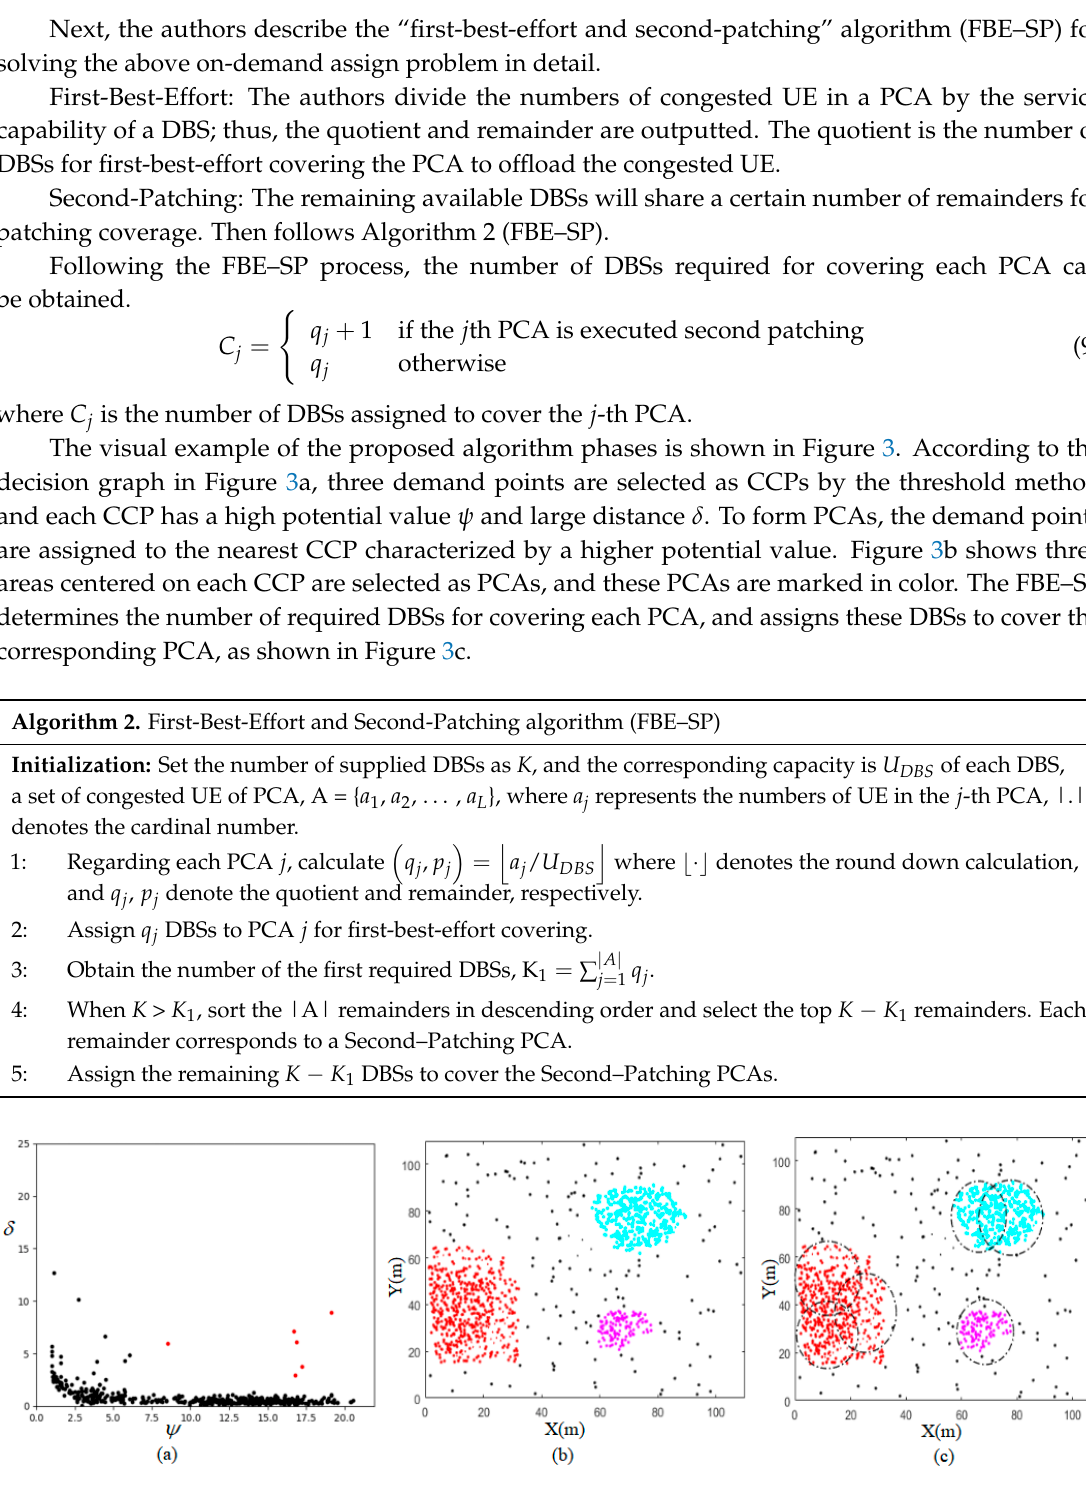
Figure 3. The visual example of the proposed algorithm phases: ( a ) Decision graph phase, ( b ) Deciding PCAs phase and ( c ) Placing-and-Operating the DBSs phase.